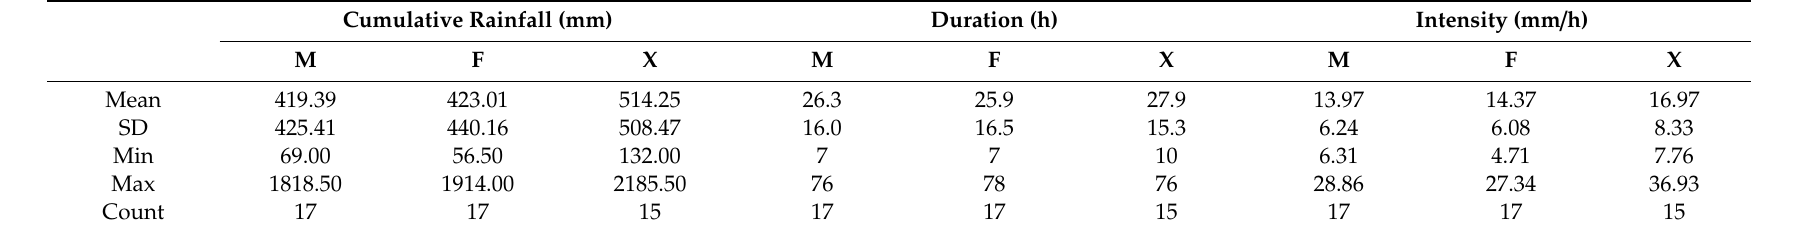
Table 6. Summary statistics for rainfall parameters derived from rain gauges at three CWB stations.